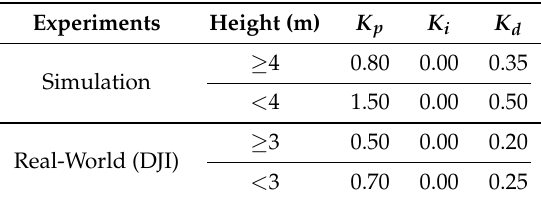
Table 2. The PID control